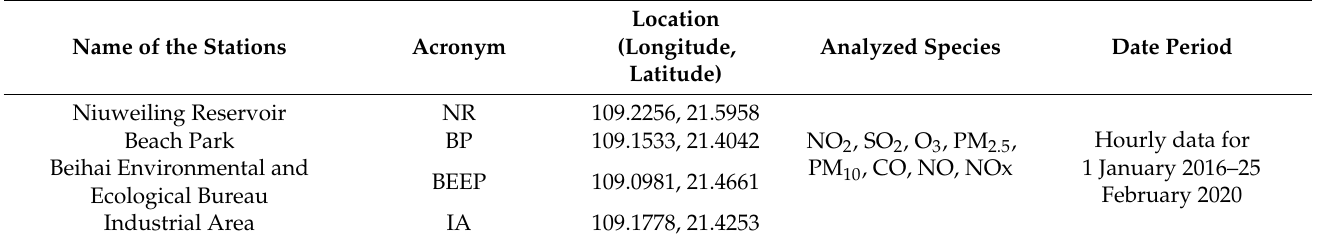
Table 1. Characteristics of measuring stations: name and acronym, location, analyzed pollutants and periods of data